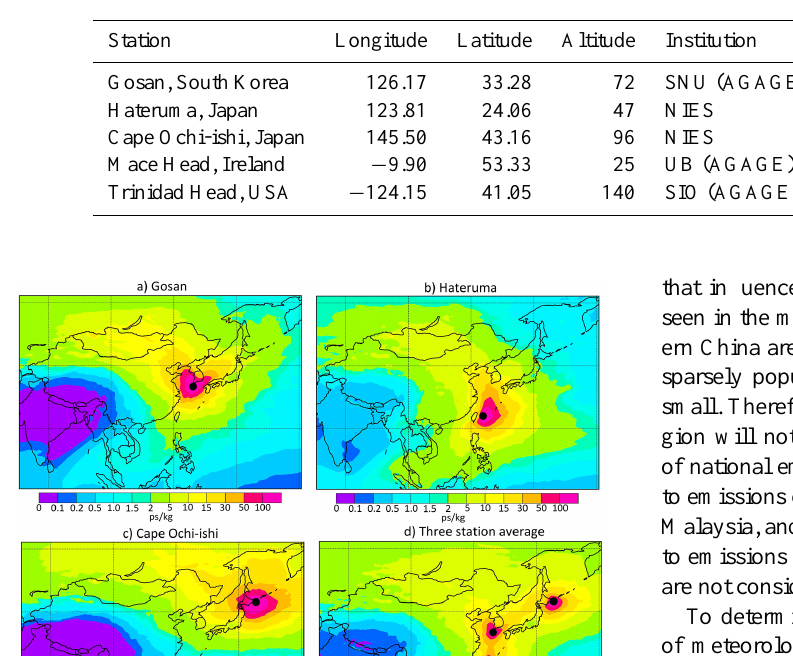
Table 1. List of the measurement stations, corresponding coordinates, the operating institutions and the period of available data used in this study.